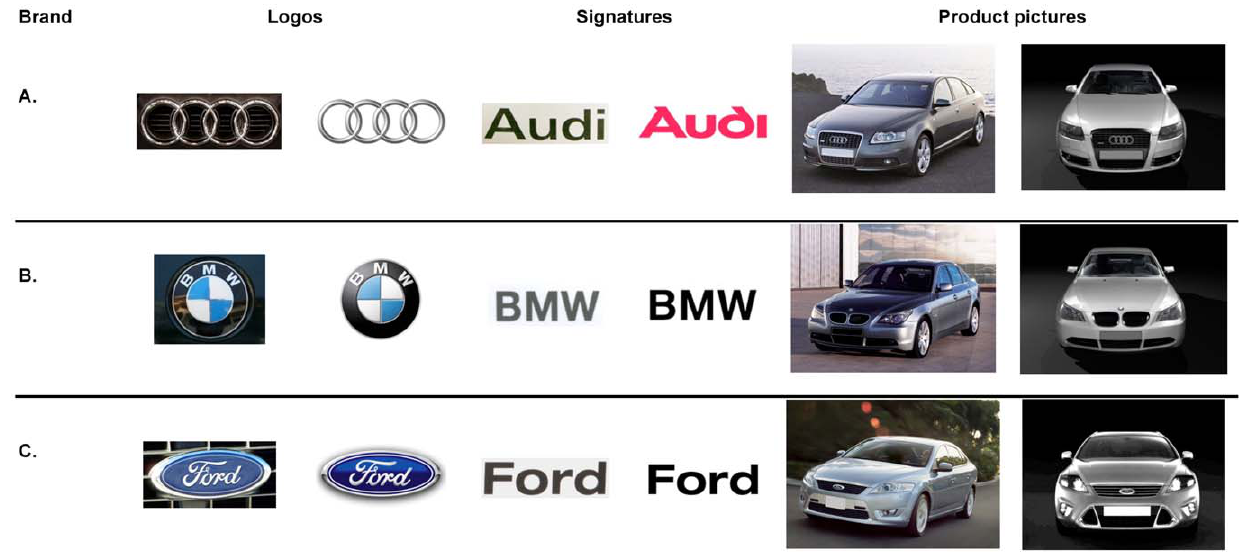
Figure 1. Images used to represent the brands AUDI, BMW, and FORD, varying according to the factor BRAND CUE. doi:10.1371/journal.pone.0015849.g001 PLoS ONE |